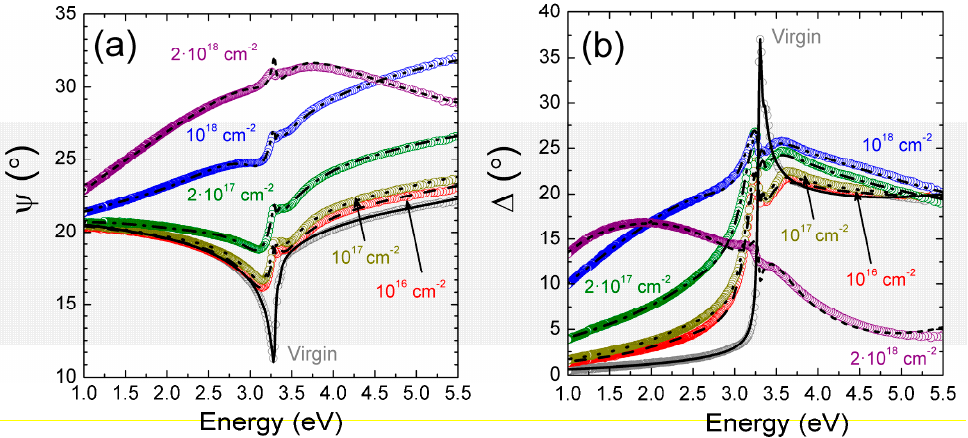
Figure 6. Experimental data (dots) and best fits (lines) for ψ ( a ) and ∆ ( b ) ellipsometric parameters of the ZnO irradiated samples at the different studied fluences.